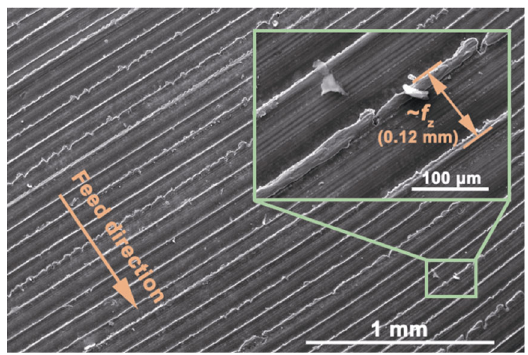
Fig. 11 Machined surface of Inconel 718